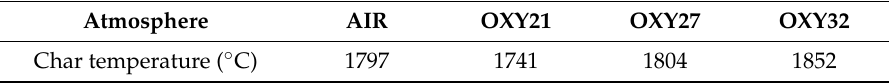
Table 3. Char particles average burning temperature during oxy-fuel combustion.